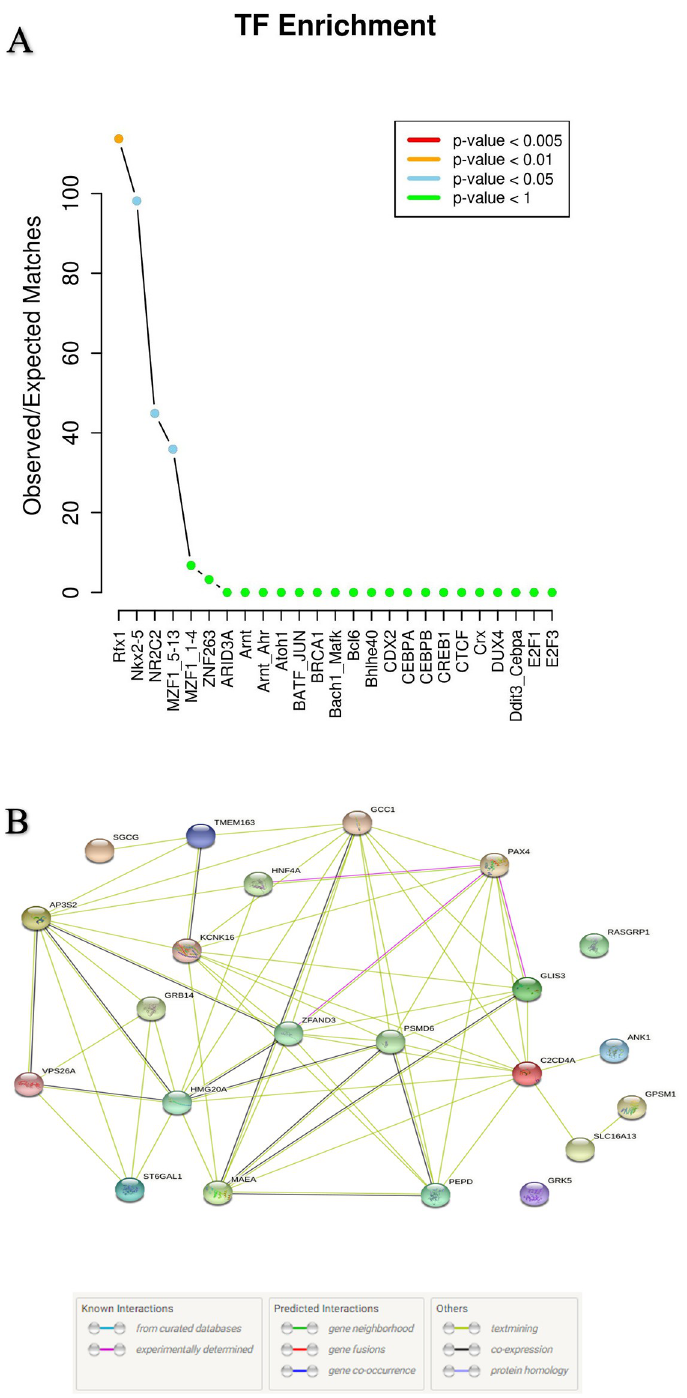
Fig 1. Functional prediction and protein-protein interaction of T2D risk genes and SNPs. (A) Transcription factors (TF) enrichment, TFs are sorted based on their enrichment. (B) Protein-protein interaction of T2D risk genes. In protein-protein interaction, connections are based on co-expression and experimental evidence. Each filled node denotes a gene; edges between nodes indicate protein-protein interactions between protein products of the corresponding genes. Different edge colors represent the types of evidence for the